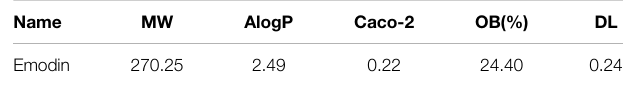
TABLE 1 | Properties of emodin. TABLE 2 | Interrelated protein target